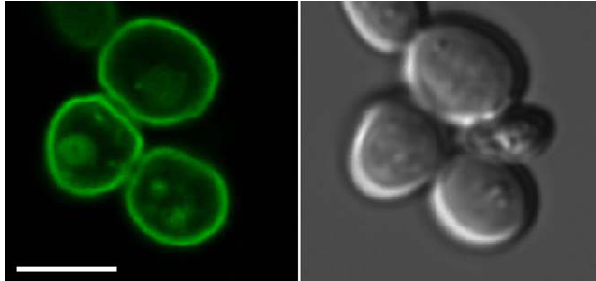
Figure 7. Subcellular localization of Srt1 in S. cerevisiae . A functional Srt1::GFP fusion protein localizes specifically to the plasma membranes of S. cerevisiae . The fusion construct was expressed under the control of the S. cerevisiae pma1 promoter. The left image was taken under GFP excitation light; the corresponding image under transmis- sion light is shown on the right side. The scale bar represents 5 m m.